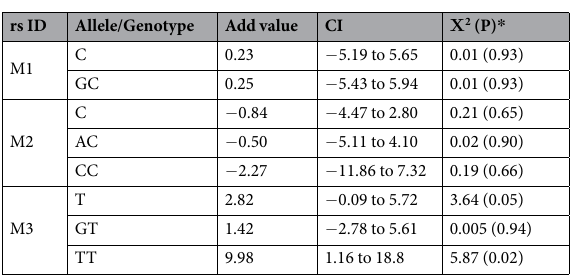
Table 6. Quantitative Trait analysis involving gene variants and improvement in ADHD